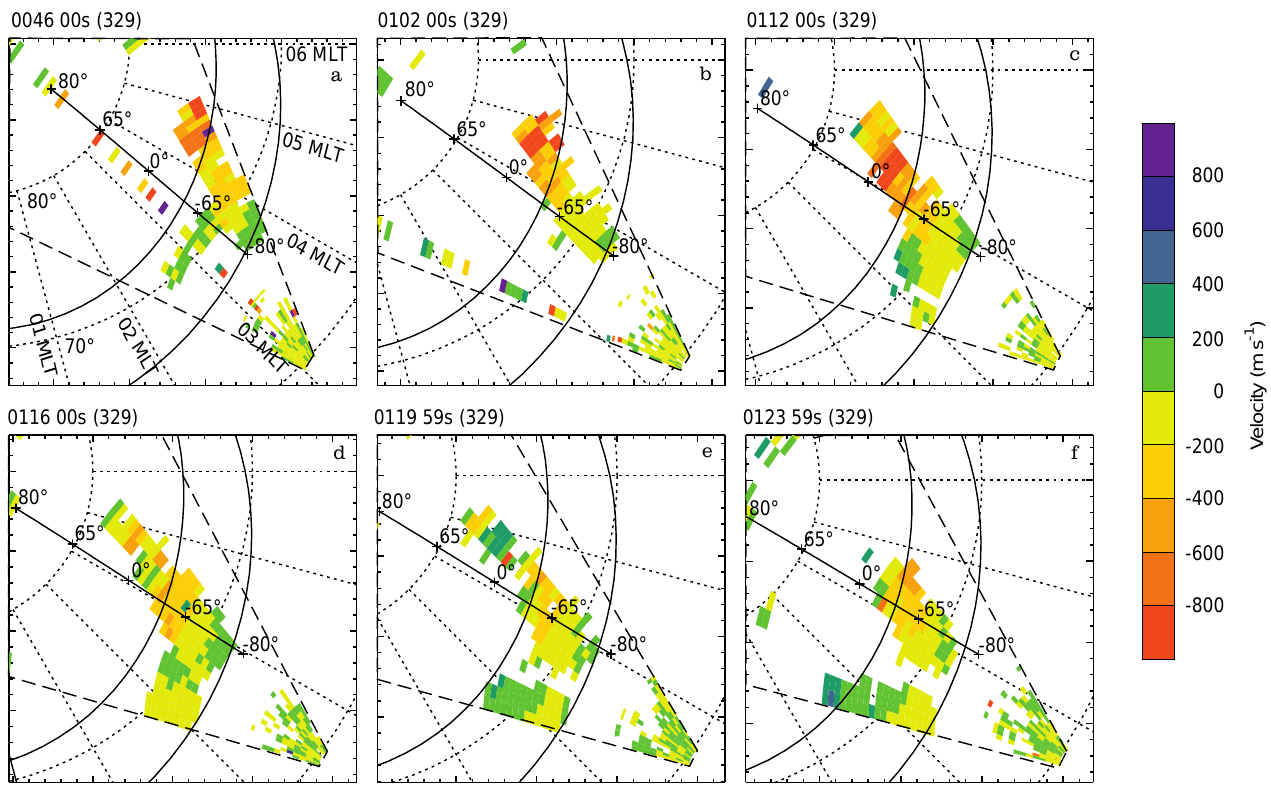
Fig. 4. Spatial plots, in GMLAT/MLT coordinates, of the CUTLASS Finland backscatter at six times between 0046 UT and 0124 UT. The dashed lines represent the edges of the radar field-of-view. The locations of the MSP meridian and the auroral oval (cid:133) K p (cid:136) 1 (cid:134) are also